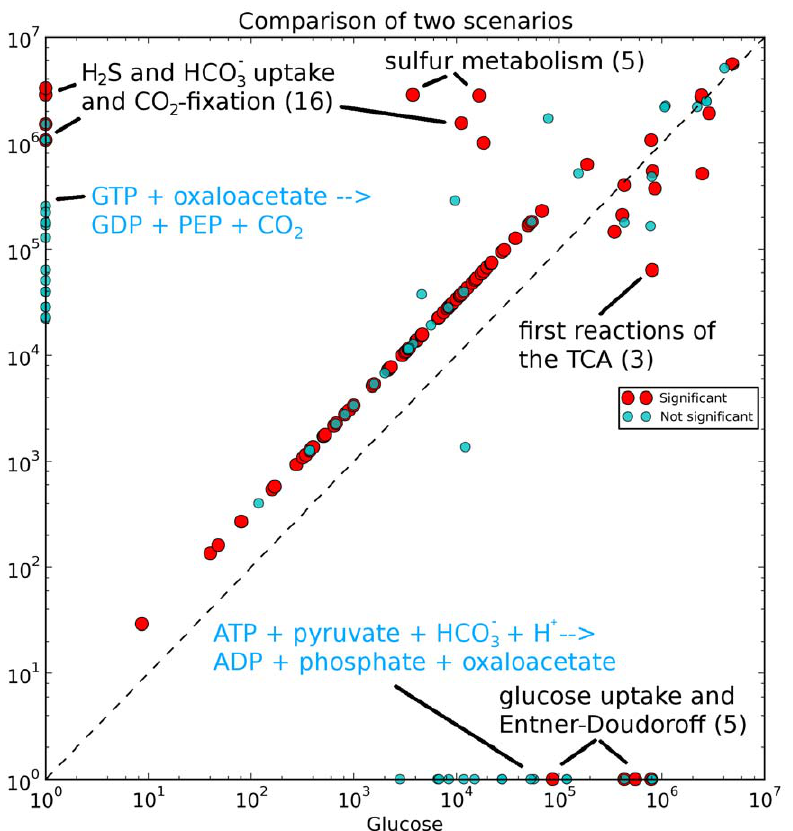
Figure 5. Scatter plot of the flux distributions during growth on glucose and the carbon fixation scenario. Red dots show significant differences, and blue dots show not significant differences between both scenarios. Blue labels describe not significant differences. The numbers indicate the number of involved reactions.